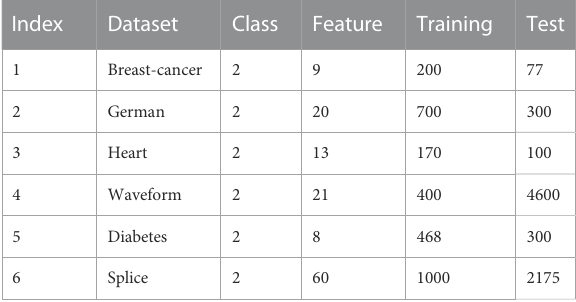
TABLE 3 Characteristics of datasets used in experiments.